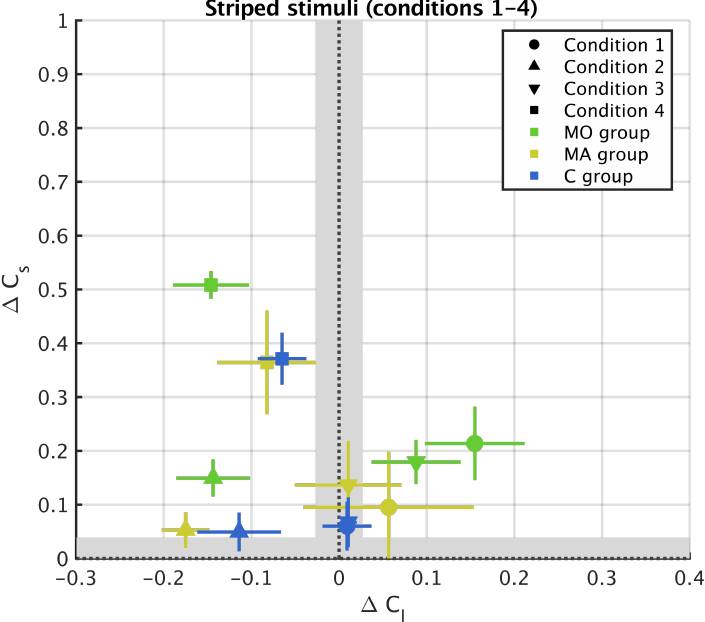
Figure A1. Similar to Figure 4, the colour induction is shown for the three different groups. Here, we present the results for the 11 stripes